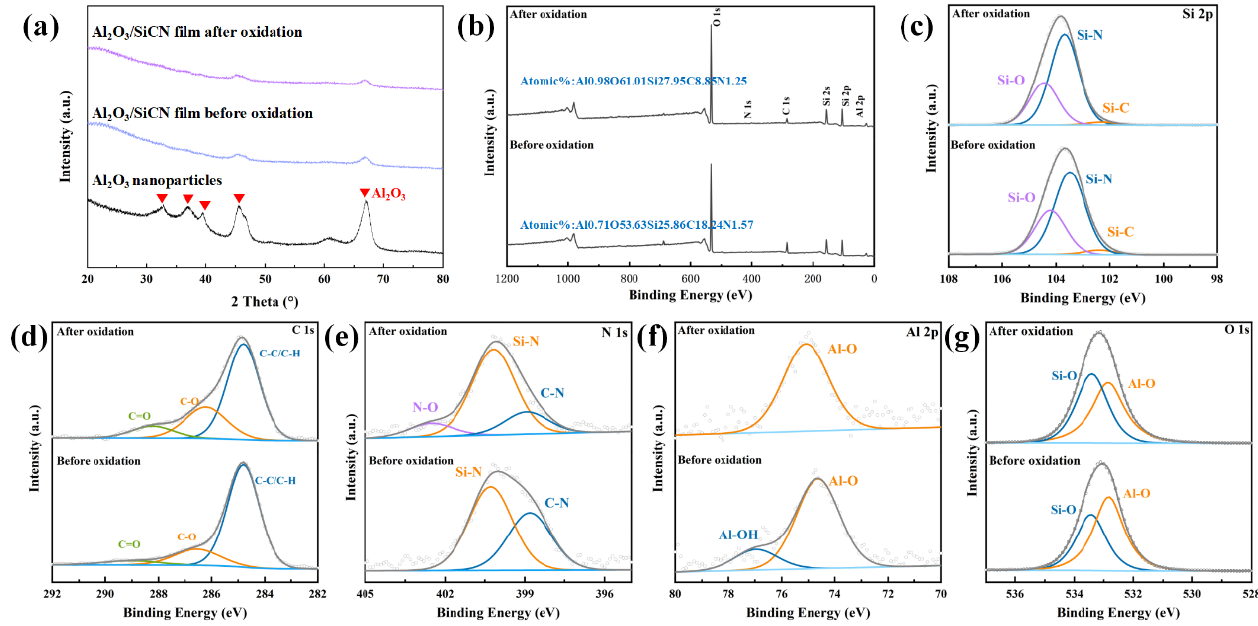
Figure 5. ( a ) XRD patterns of Al 2 O 3 filler and Al 2 O 3 /SiCN film. XPS spectra of the as-prepared Al 2 O 3 (20 wt%)/SiCN film: ( b ) XPS spectra, ( c ) Si 2p, ( d ) C 1s, ( e ) N 1s, ( f ) Al 2p, and ( g ) O 1s.